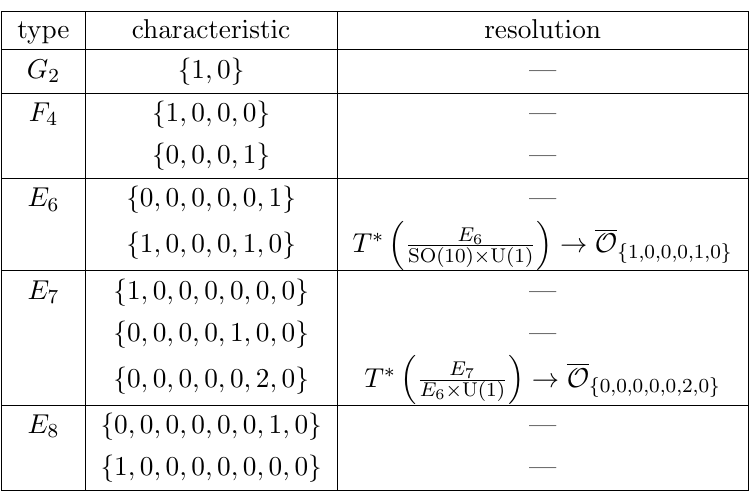
Table 9 . Summary of resolutions of height two nilpotent orbits for classical algebras.